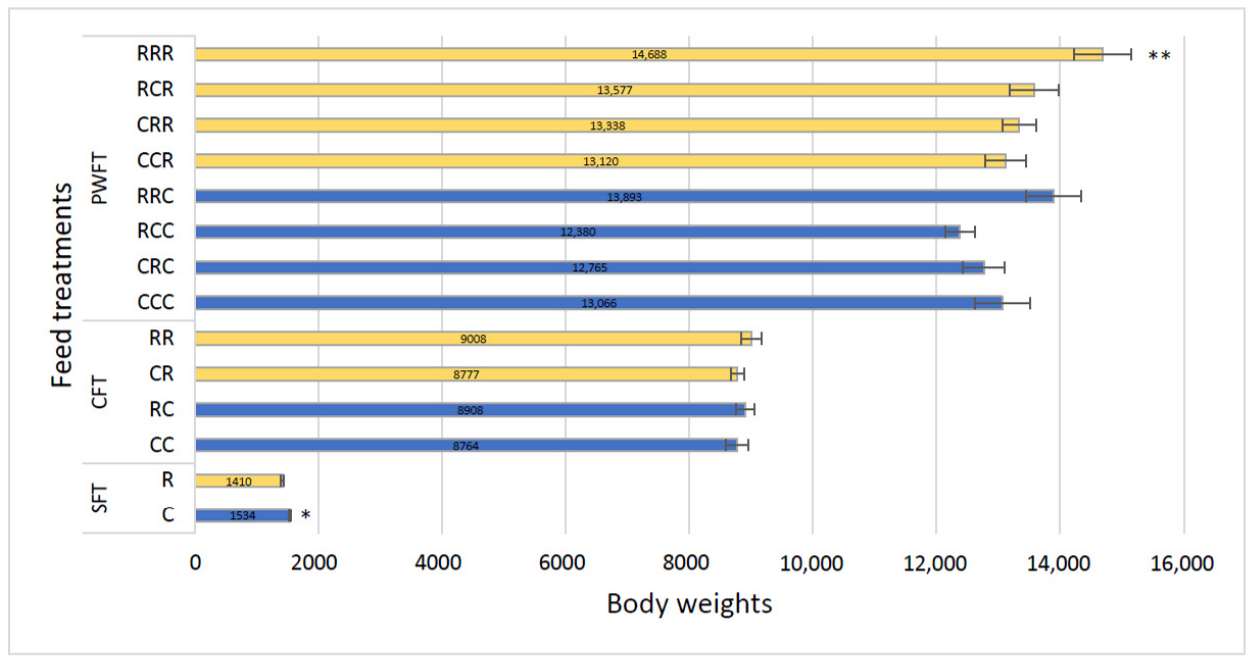
Figure 3. Body weights of piglets at different ages. SFT = Sow feed treatment piglets, CFT = Creep feed treatment piglets, PWFT = Post-weaning feed treatment piglets. C = Control feed of sows, R = RAC feed of sows, RR = sow RAC feeding- piglets RAC creep feeding, RC = sow RAC feeding-piglets control creep feeding, CR = sow control feeding-piglets RAC creep feeding, and CC = sow control feeding-piglets control creep feeding. RRR = sow RAC feeding-piglets RAC creep feeding-piglets post-weaning RAC feeding: RRC = sow RAC feeding-piglets RAC creep feeding-piglets post-weaning control feeding: RCR = sow RAC feeding-piglets control creep feeding-piglets post-weaning RAC feeding: RCC = sow RAC feeding-piglets control creep feeding-piglets post-weaning control feeding: CRR = sow control feeding-piglets RAC creep feeding-piglets post-weaning RAC feeding: CRC = sow control feeding-piglets RAC creep feeding-piglets post- weaning control feeding: CCR = sow control feeding-piglets control creep feeding-piglets post-weaning RAC feeding: and CCC = sow control feeding-piglets control creep feeding-piglets post-weaning control feeding.* p < 0.05, ** p <